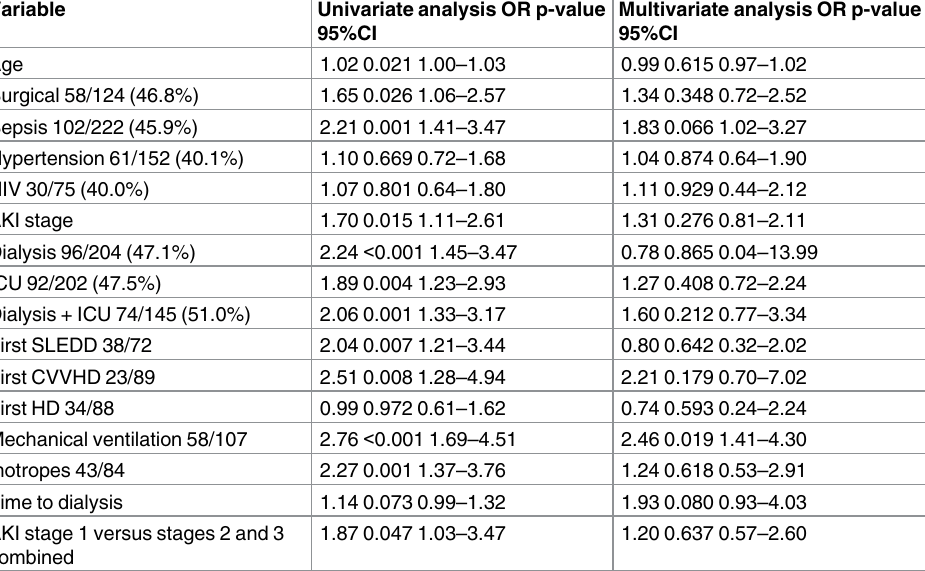
Table 4. Univariate and multivariate analysis of potential risk factors for 90 day